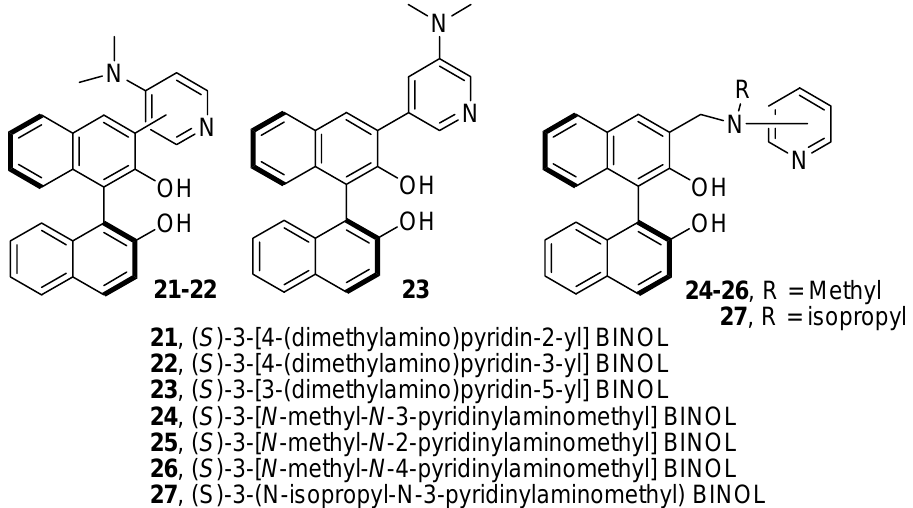
Figure 7. Several Biphenols derivatives used as catalyst for MBH reaction between methyl vinyl ketone and phenyl N -tosylimine.